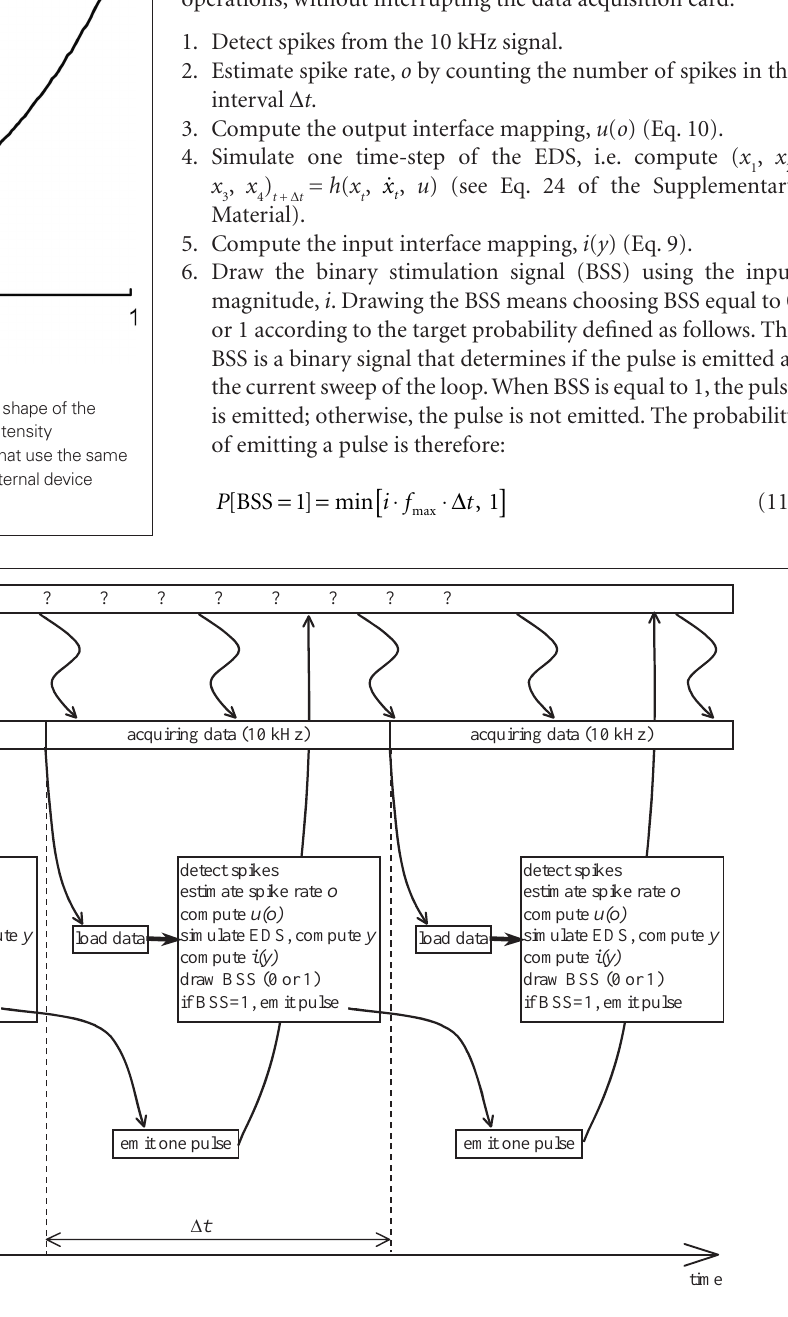
FIGURE 5 | Temporal structure of the experiment. EDS stands for external dynamical system, BSS stands for binary stimulation